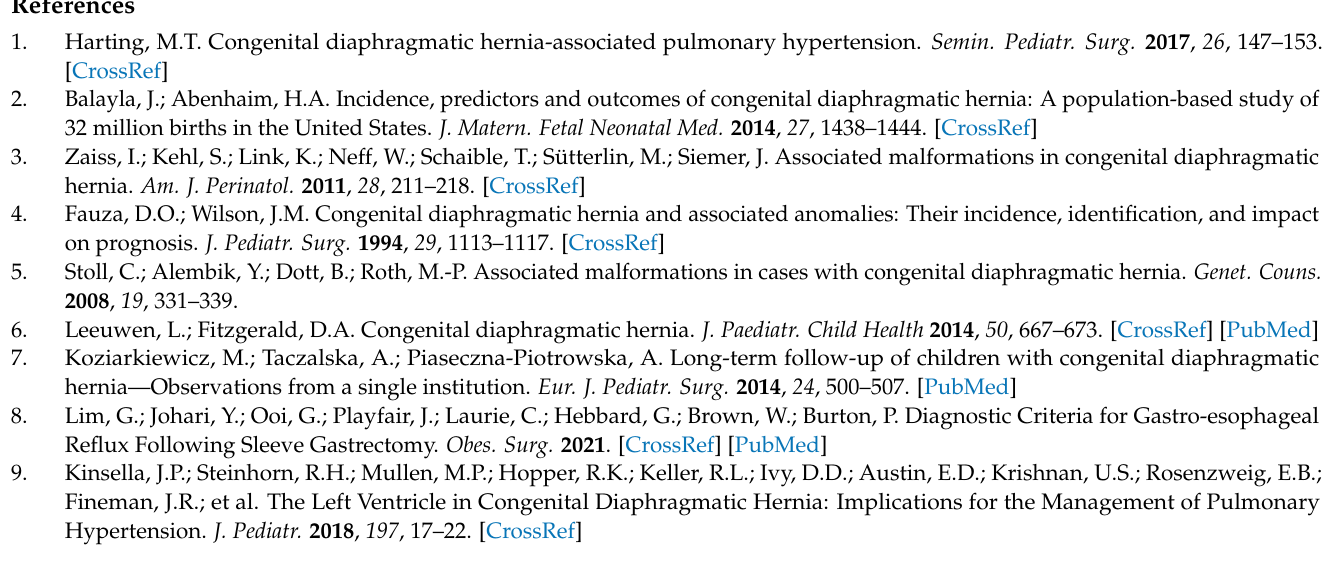
Figure S3: Comparison between NCDH-NC (effect of lung compression on the fetal lung metabolism) and NC-VC (effect of nitrofen causing lung hypoplasia on the lung metabolism), Figure S4: Functional analysis of metabolic pathways in nitrofen-CDH model (NCDH) compared to nitrofen control (NC) and NC compared to vehicle control (VC), Figure S5: Nitrofen CDH rat model (created with